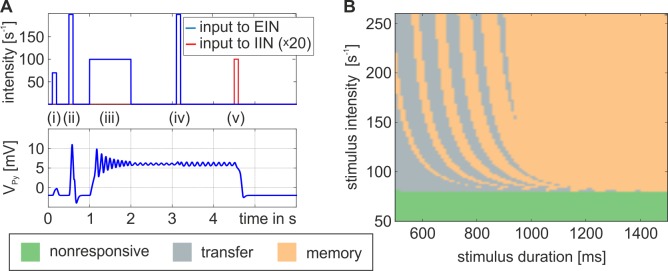
Aspects of the models’ responsiveness to afferent stimuli arriving at the EIN of the three population model.A) Depending on the salience of the applied stimuli in terms of duration and intensity, three distinct response behaviors were observed: (1) a nonresponsive behavior following weak and brief stimulation, where the Py’s membrane potential, VPy, responds only with a small deflection below a firing threshold, see impulse (i), (2) a transfer behavior following a strong and brief stimulation, where VPy exceeds a firing threshold, see impulse (ii), and (3) a memory behavior following longer stimulation of medium intensity, see impulse (iii), for which the system can settle down on a stable state of higher activation. In this state the system is insensitive to further stimuli, or noise, (see impulse (iv)), but can be actively reset through a weak and brief impulse to the IIN, clearing the memory trace, see impulse (v). Please note that this IIN impulse was enlarged by a factor of 20 to improve clarity. B) The response behaviors depend on the salience of the input. A nonresponsive behavior is shown for intensities below 78s-1 (green region). Exceeding this intensity, a longer stimulus is able to reliably evoke the memory behavior (orange region). The shorter the stimulus the more likely the transfer behavior (grey region) becomes, where the stripe-like patterns signify a dependency of the behavior (transfer or memory) on the phase relation between stimulus switch-off time and the intrinsic system oscillation. For the plotted curves we used b1 = 1, b2 = 1, He = 3.25mV, and Hi = 22mV.